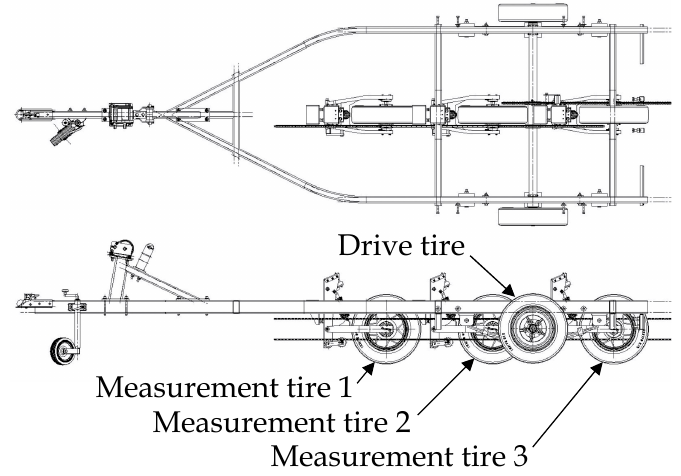
Figure 8. Fundamental design for trailer [21].